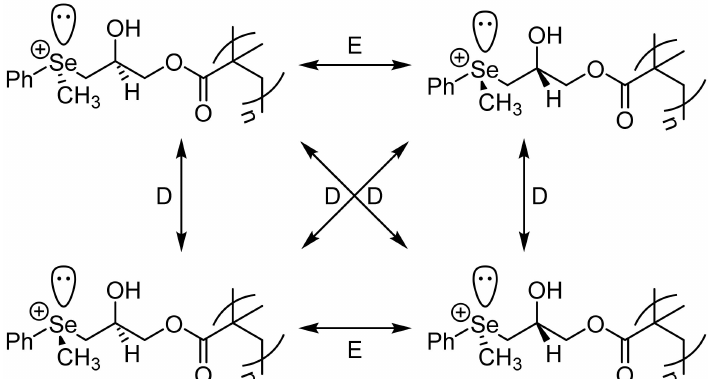
Figure 7. Stereochemical considerations upon alkylation of the ß-hydroxy selenide linkage in organoselenium polymers (S = stereoisomer, D = diastereomer).